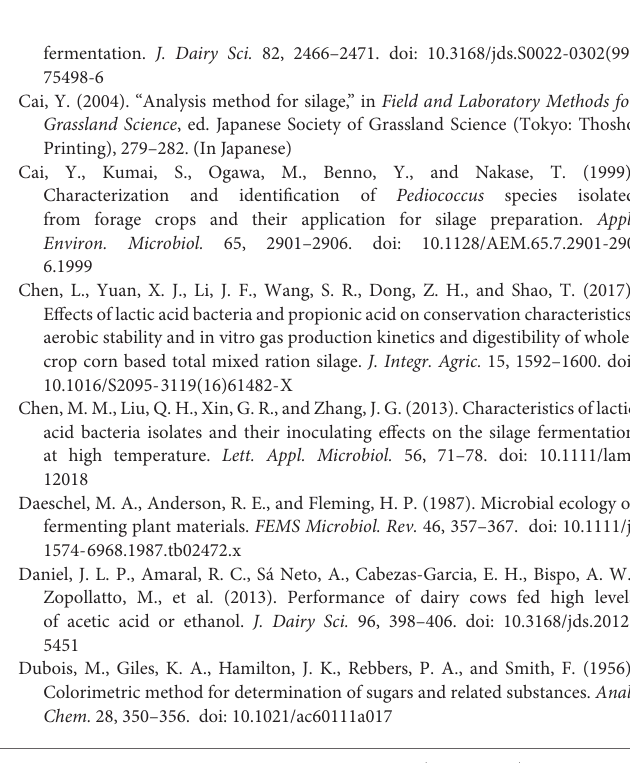
Supplementary Table 1 | API 50 CH fermentation patterns of isolated LAB from each FJLB. Supplementary Table 2 | Diameter of inhibition zones caused by the selected strains of LAB which were added to agar plates inoculated with either Escherichia coli ATCC 25922 ( E. coli ), Shigella sonnei ATCC 25931 ( S. sonnei ), Pseudomonas aeruginosa ATCC 27853 ( P. aeruginosa ), or Bacillus cereus ATCC